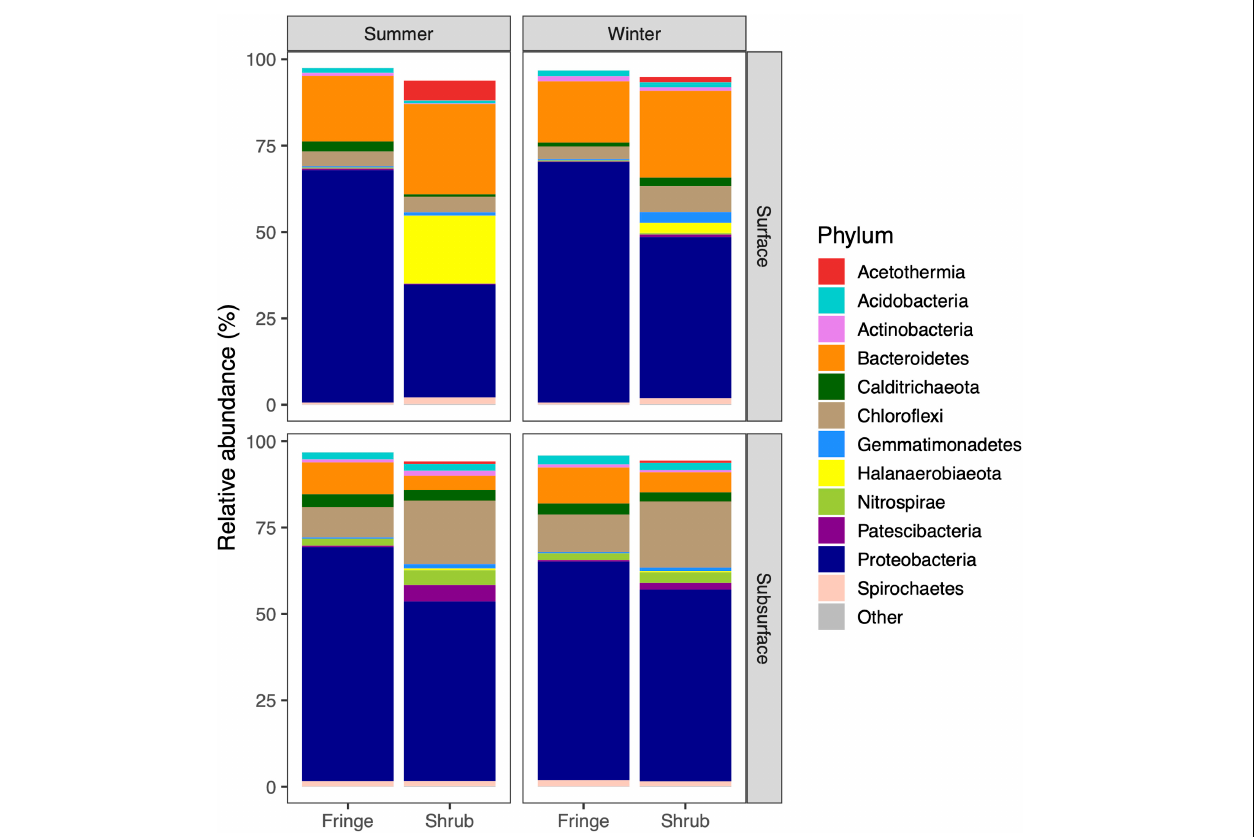
FIGURE 5 | Phylum based composition of bacterial community based on 16S rRNA amplicon sequencing. The 12 most prevalent phyla across seasons, zones, and depths are shown while less abundant phyla were grouped as “Other.” Mean relative abundances taken from all replicates are presented